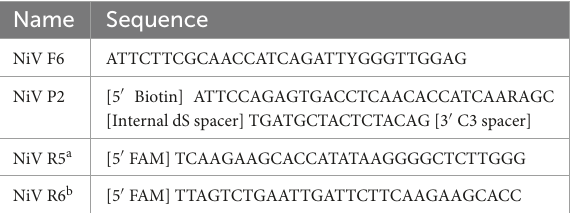
TABLE 1 Primer and probe sequences for the rapid Nipah virus (NiV)